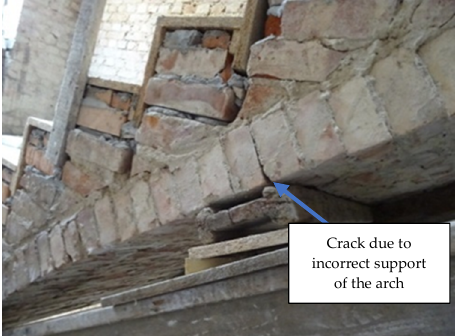
Figure 7. Section of the staircase with visible crack of the arch caused by improper renovation and deterioration of masonry joints.